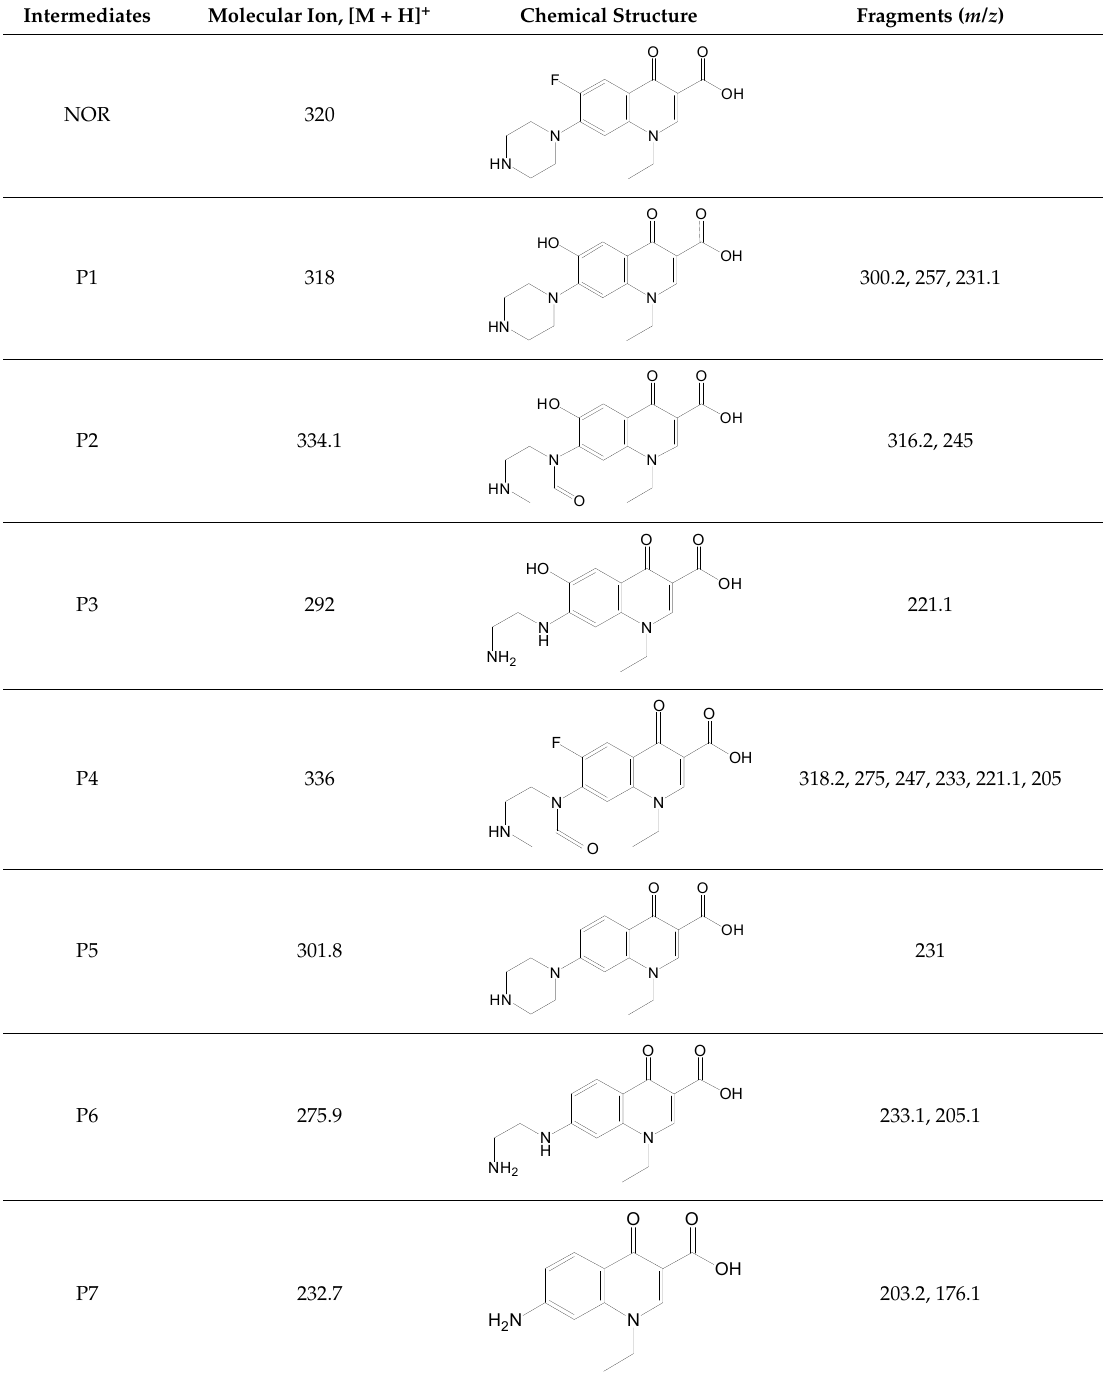
Table 5. The information of intermediates formed in the MW/UV degradation of NOR. Molecular Ion, Intermediates [M + H] +